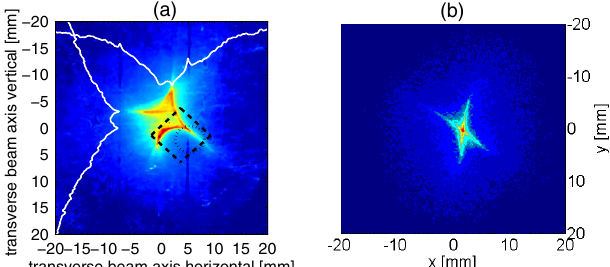
FIG. 4. Measured transverse beam profile of the focused en- ergy (a) 9.4 MeV and (b) 5 MeV at a distance to the source of 1.07 m. In both cases the spot was around 5 mm in diameter and contained (a) 4 (cid:3) 10 8 and (b) 1 : 6 (cid:3) 10 9 protons.